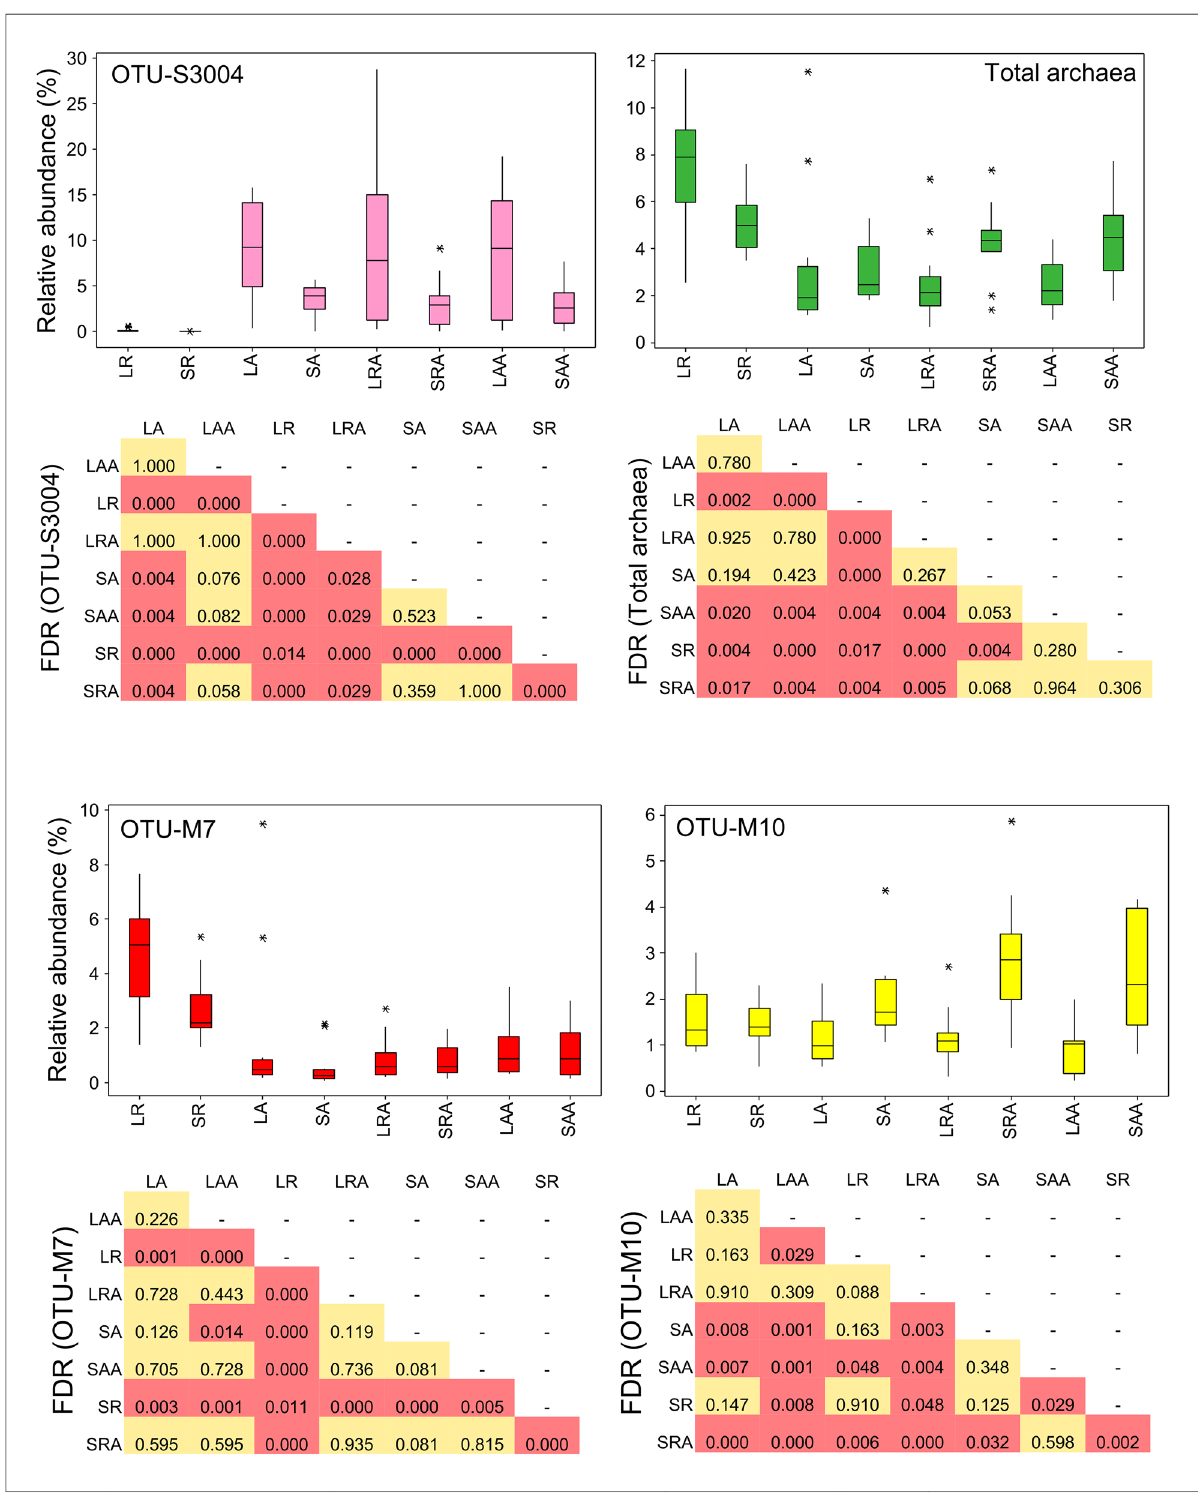
Fig 6. Relative abundances of OTUs S3004, M7 and M10 and total archaea. LR = Liquid Restricted (n = 14), SR = Solid Restricted (n = 14), LA = Liquid Ad lib (n = 13), SA = Solid Ad lib (n = 13), LRA = Liquid Restricted/ Ad lib (n = 15), SRA = Solid Restricted/ Ad lib (n = 15), LAA = Liquid Ad lib / Ad lib (n = 13), SAA = Solid Ad lib / Ad lib (n = 13). FDR = BH-corrected P values from Wilcoxon pairwise comparisons of relative abundances between different treatment groups.